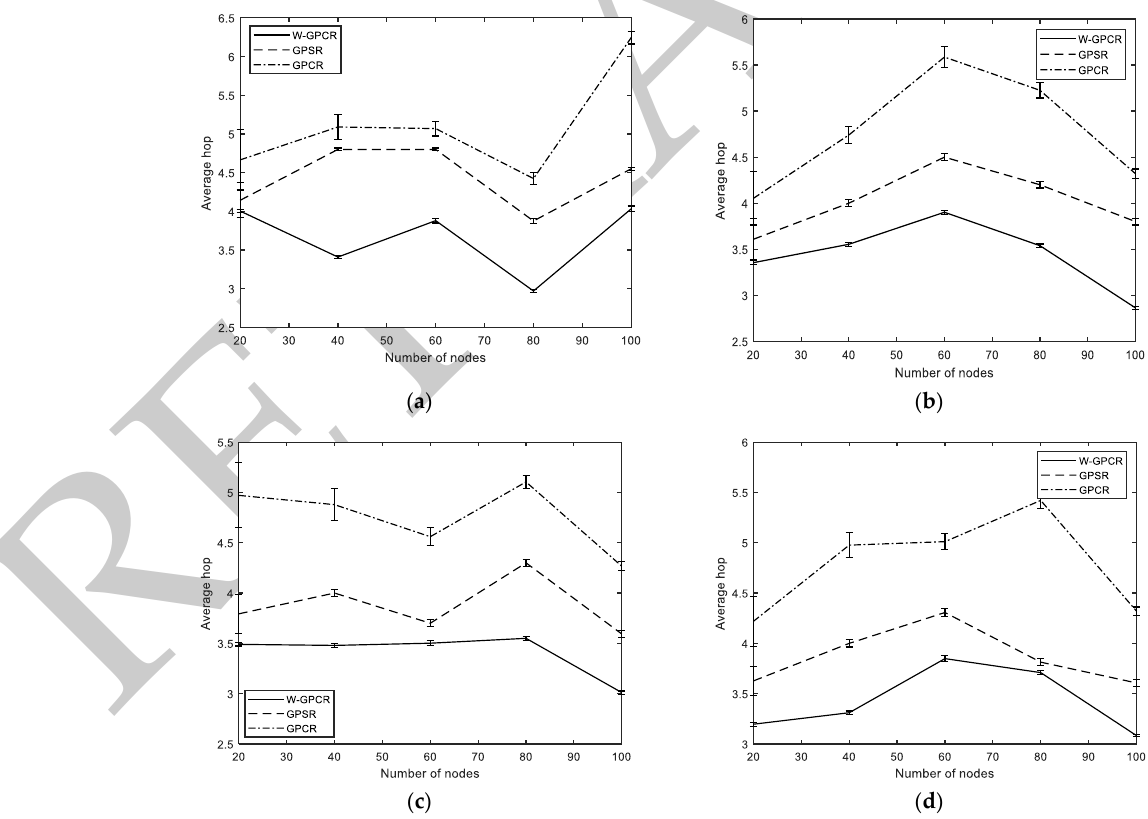
Figure 9. Average hop for varying the number of nodes and CBR connections: ( a ) 5 CBR connections; ( b ) 10 CBR connections; ( c ) 15 CBR connections; ( d ) 20 CBR